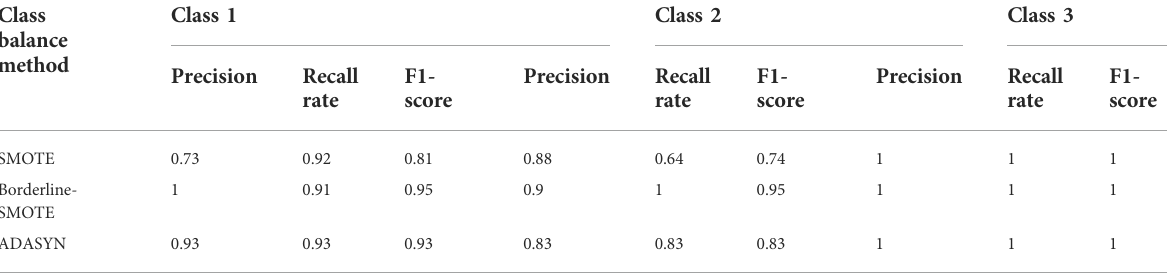
TABLE 8 Comparison of class balance methods with different classes using the Wine dataset.